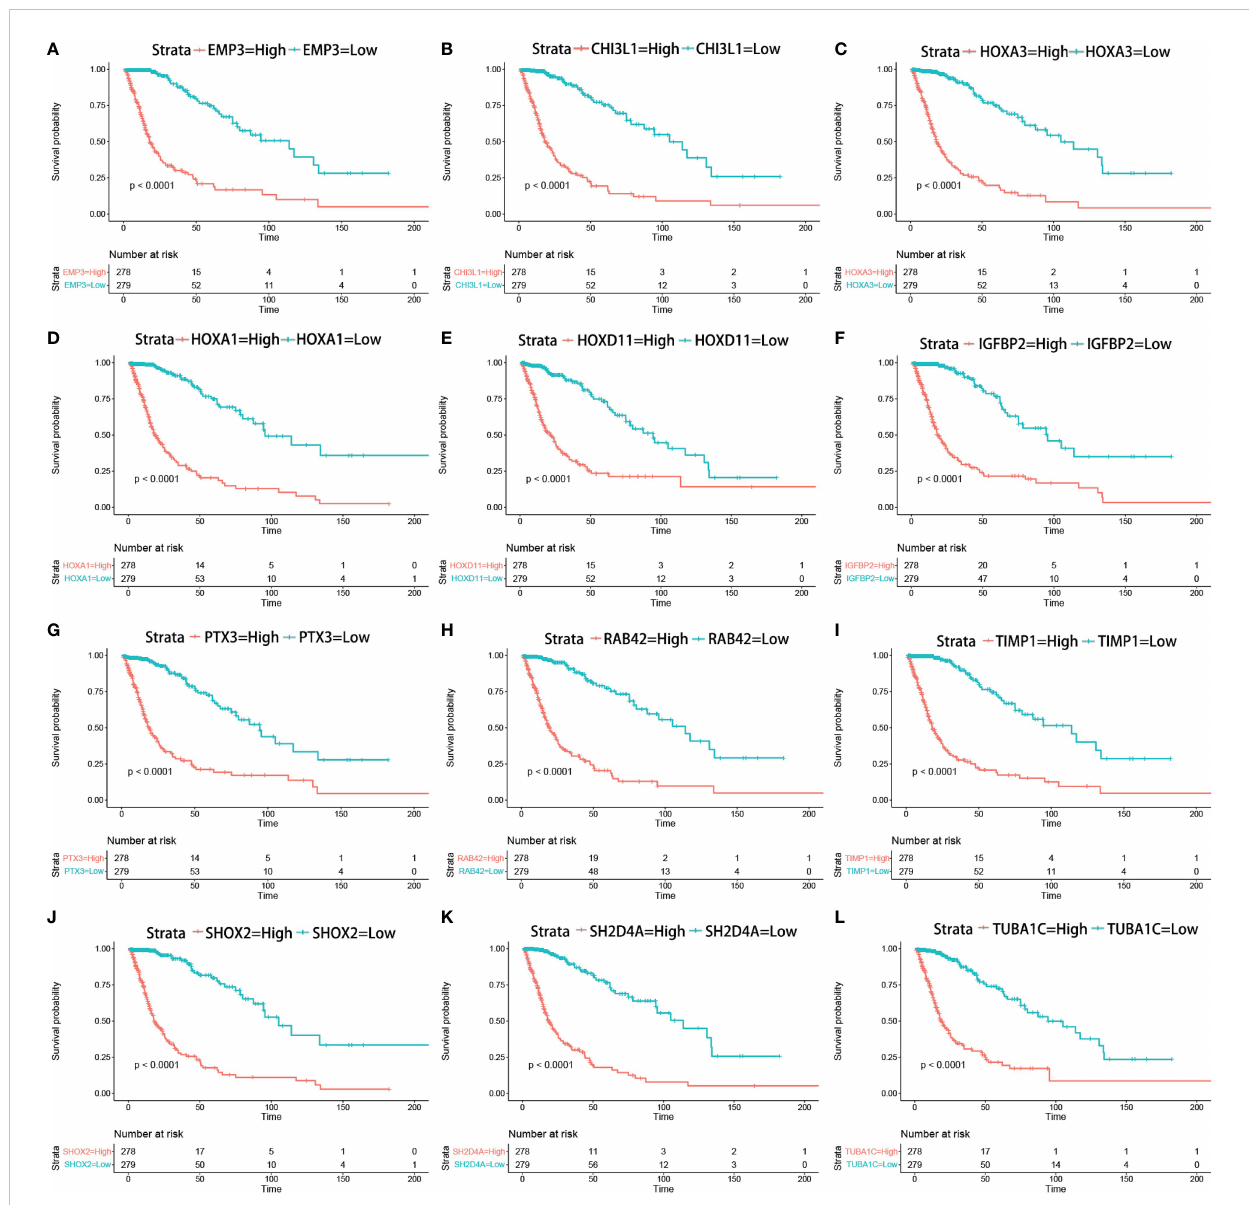
FIGURE 8 Kaplan – Meier survival curves in glioma patients in TCGA show that the expression levels of key genes predicted prognosis (A – L) (Kaplan – Meier survival analysis, p < 0.0001 in log